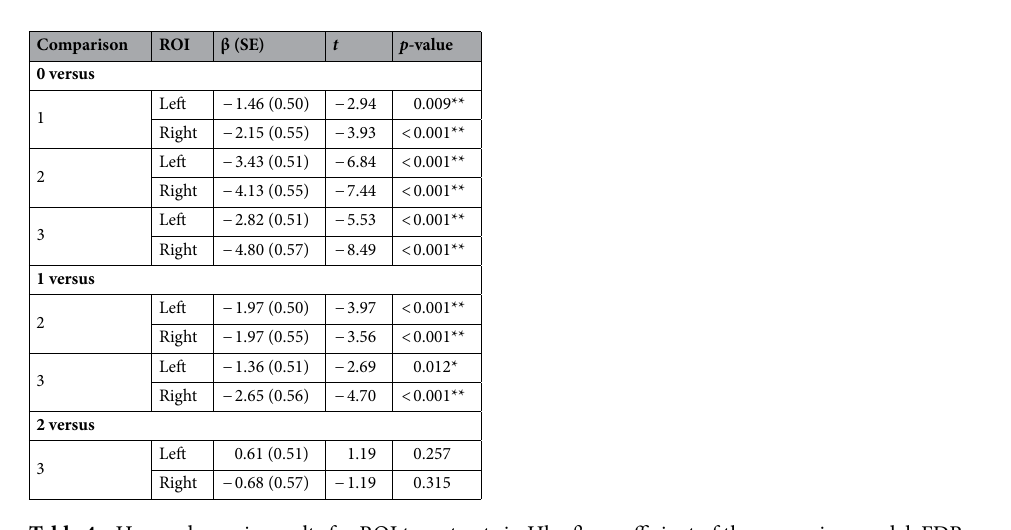
Table 4. Haemodynamic results for ROI t-contrasts in Hbr. β = coefficient of the regression model. FDR- corrected p -values 52 . Significance levels marked p < 0.05* and p < 0.01**.